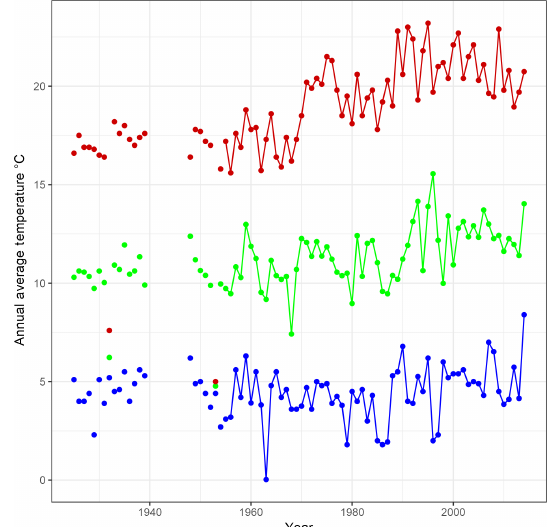
Figure 13. Average (green), minimum (blue), and maximum (red) annual temperatures for the southern North Sea including all sources and all